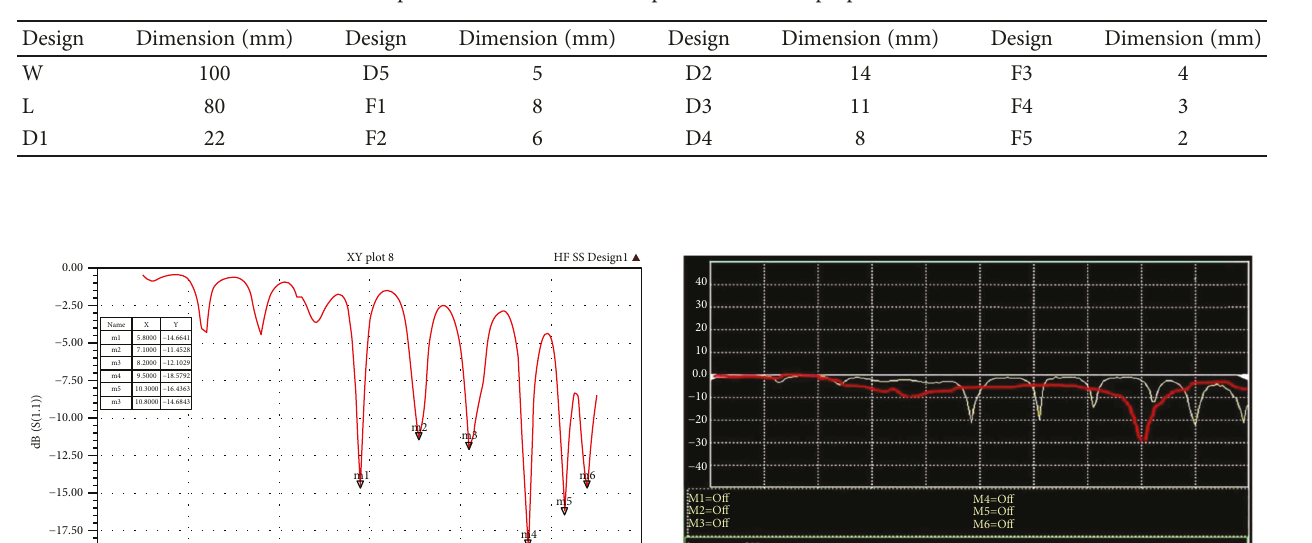
Table 1: Speci fi cations of the antenna parameters of the proposed antenna.